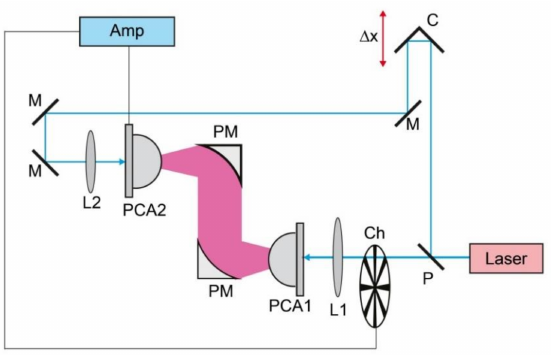
Figure 3. Schematics of the terahertz time-domain spectroscopy setup.